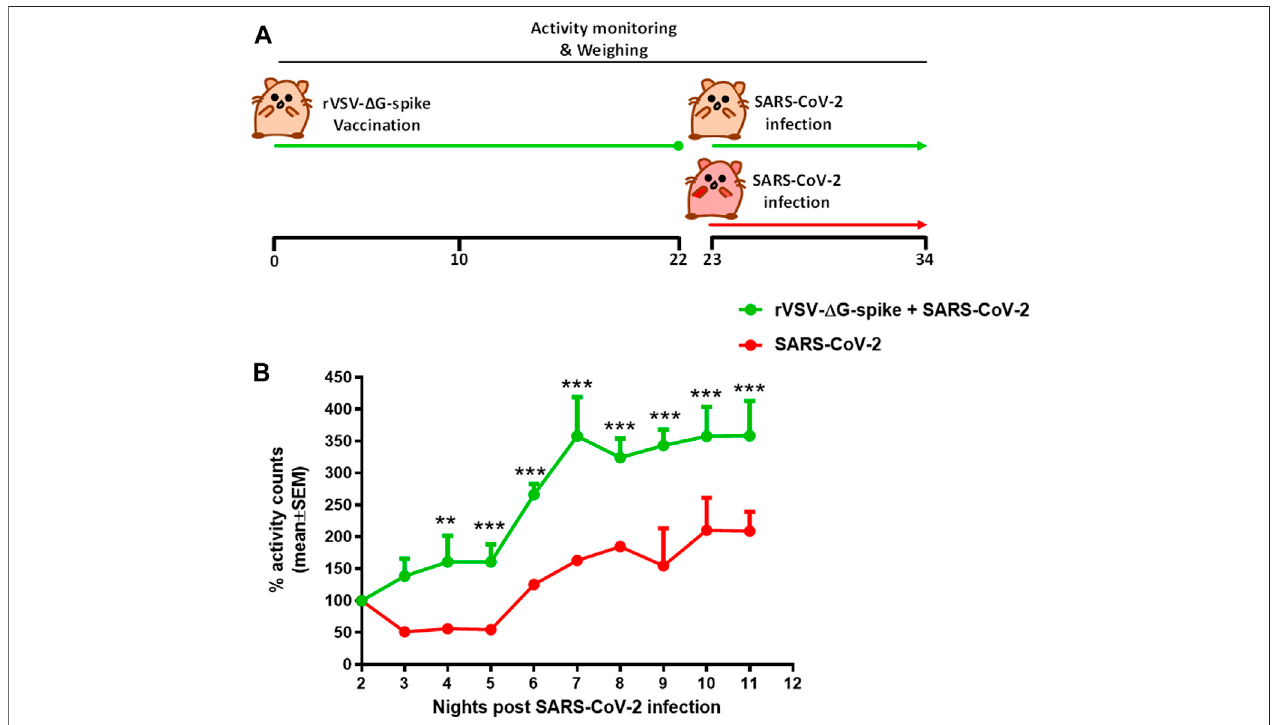
FIGURE 5 | Recovery of group activity in female hamsters vaccinated with rVSV- Δ G-spike following SARS-CoV-2 infection. (A) rVSV- Δ G-spike vaccination and SARS-CoV-2 infection scheme. (B) Recovery of nighttime group activity of immunized hamsters compared to nonimmunized, two nights after i.n. infection with 5 × 10 6 pfu of SARS-CoV-2. Recovery was determined as a percent of activity recorded at the disease state 2 days after infection. n (cid:2) 2 cages/group, 4 hamsters/cage. ** p < 0.01 and *** p <